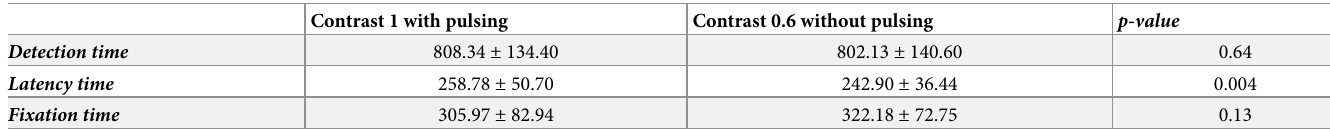
Table 4. Comparison between two options in